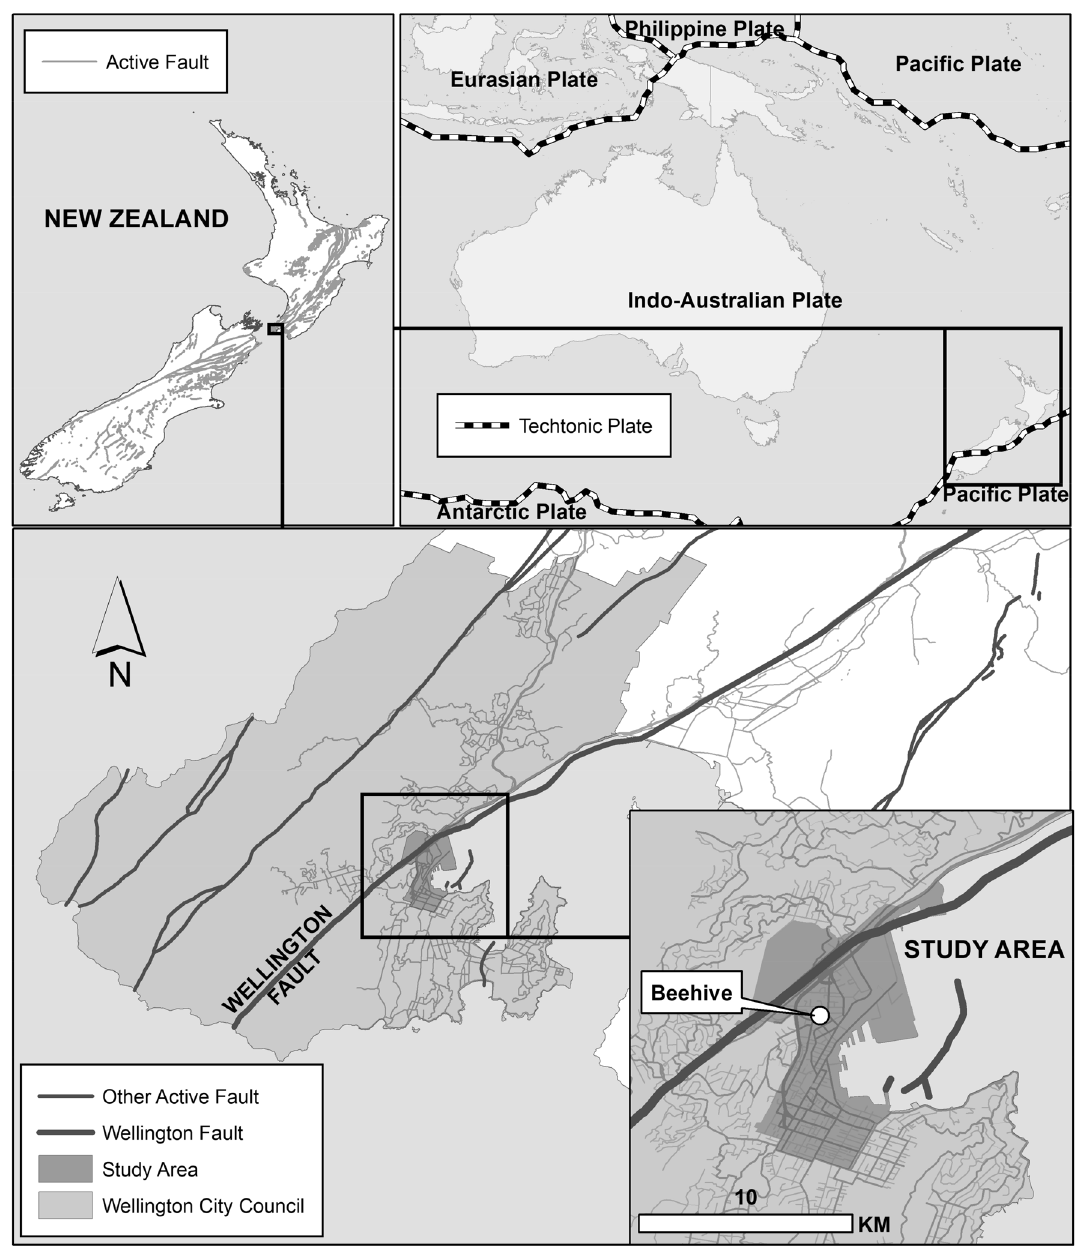
Fig. 1 Location of New Zealand active faults and extent of the study area within Wellington Source : New Zealand active faults sourced from Langridge et al.